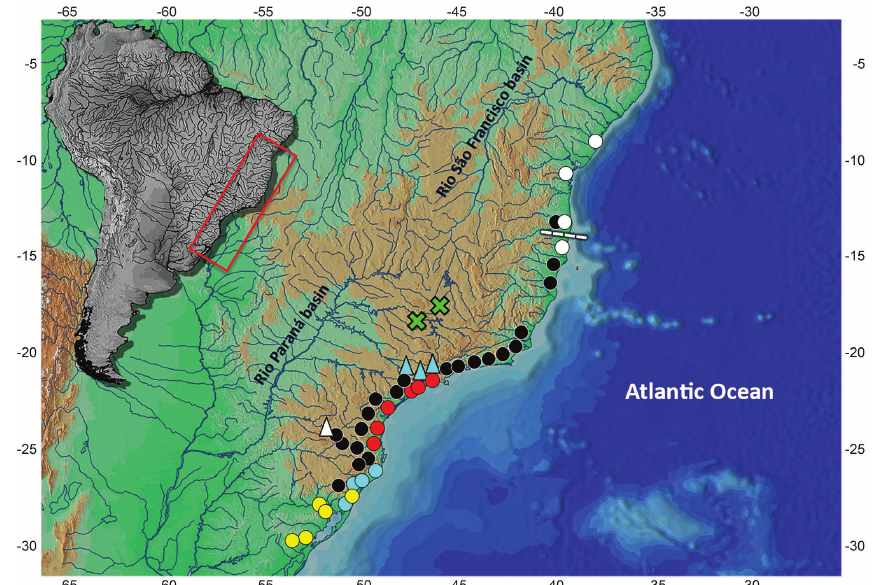
Fig 3. Map showing the updated geographical distribution of Glandulocaudini species analyzed in this study: Glandulocauda caerulea (white triangle), G. melanopleura (blue triangles), Lophiobrycon weitzmani (green crosses), Mimagoniates inequalis (blue circles), M. lateralis (red circles), M. microlepis (black circles), M. rheocharis (yellow circles), and M. sylvicola (white circles). Symbols above the dashed line indicate the northernmost limit of the distribution of Glandulocaudini based on the new records obtained in this study. Some collection points from Menezes et al. (2008: fig.